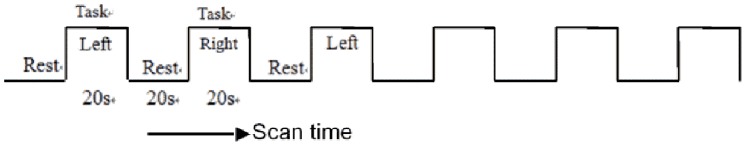
Paradigm design.